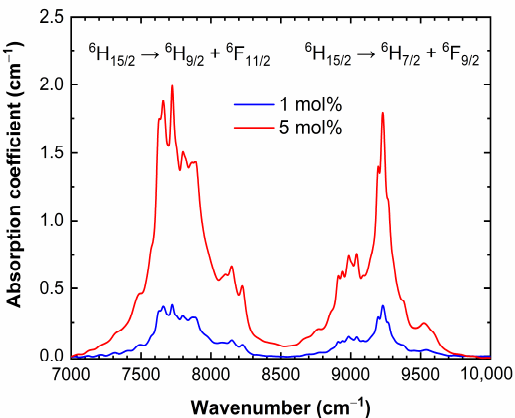
Figure 2. The absorbance of 1 and 5 mol% Dy 3+ doped LYB crystals in the 7000–10,000 cm − 1 spectral range measured at room temperature. The absorption coefficient of the 5 mol% Dy 3+ doped crystal is about five times higher compared to that of the 1 mol% doped LYB.